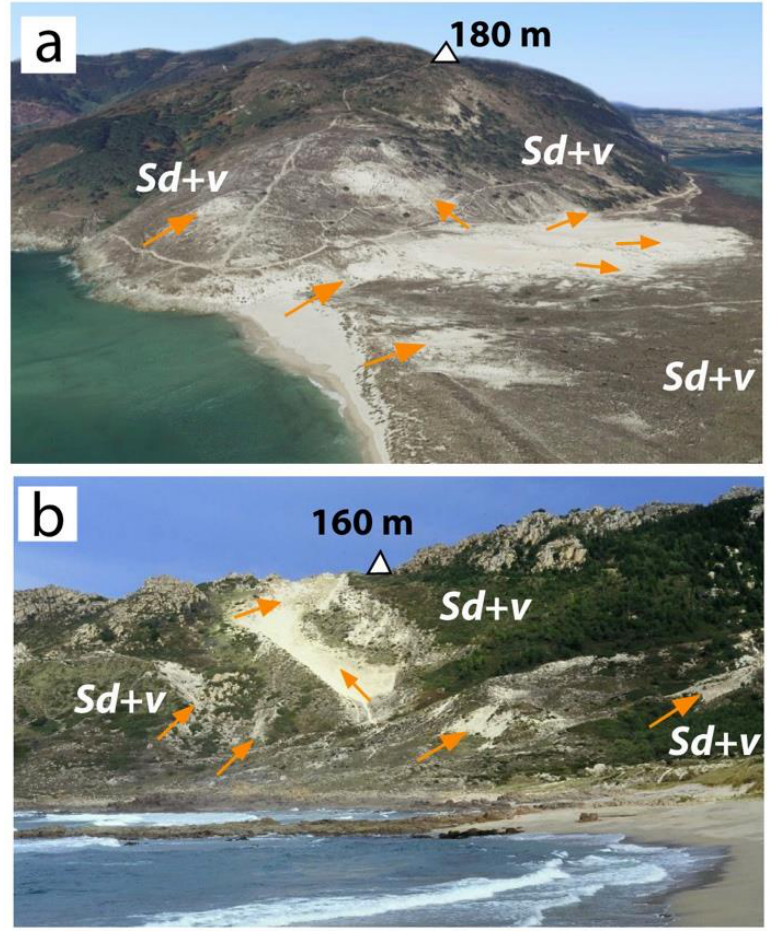
Figure 3. Relic climbing dunes from ( a ) Ponteceso (43 1 4′ N; 8 5 6′ W) and ( b ) Trece (43 1 1′ N; 9 0 8′ W) (WGS84) on the coast of A Coruña (Galicia, NW Spain), over +150 m above present sea level. Sand dunes (Sd) are currently covered by terrestrial vegetation (v) and even trees. The arrows indicate blowout erosional formations produced by wind during storm events.